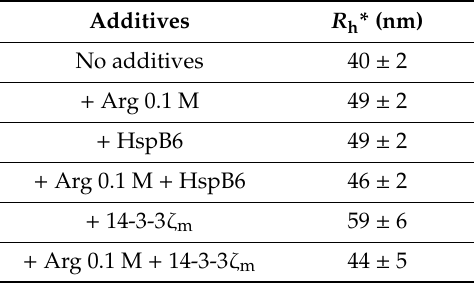
Table 1. The values of R h * for UV-Ph b aggregates in the absence and in the presence of protein chaperones and 0.1 M